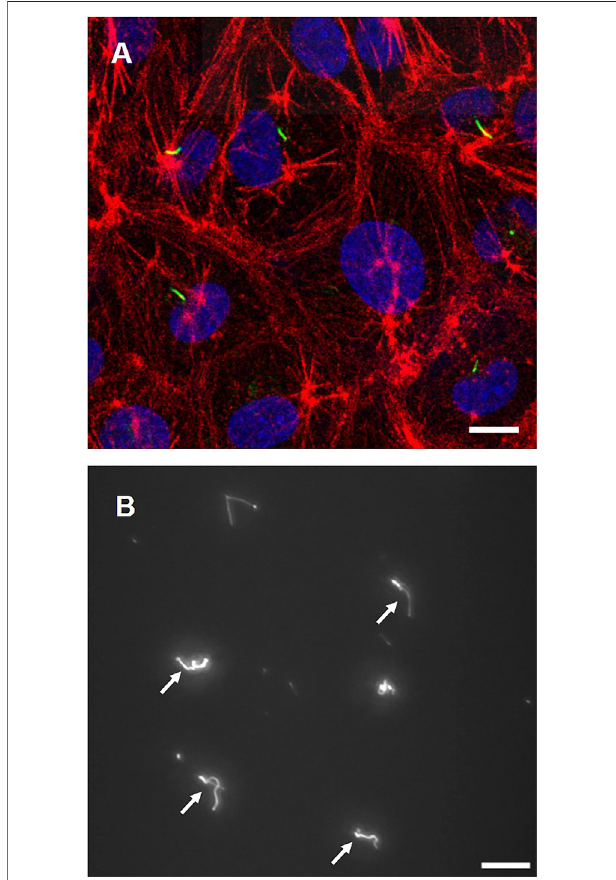
FIGURE 2 | (A) Cell images with primary cilia (green), actin fi laments (red), and nuclei (blue) (B) Isolated primary cilia after ultracentrifugation (white arrows). Scale bar: 10